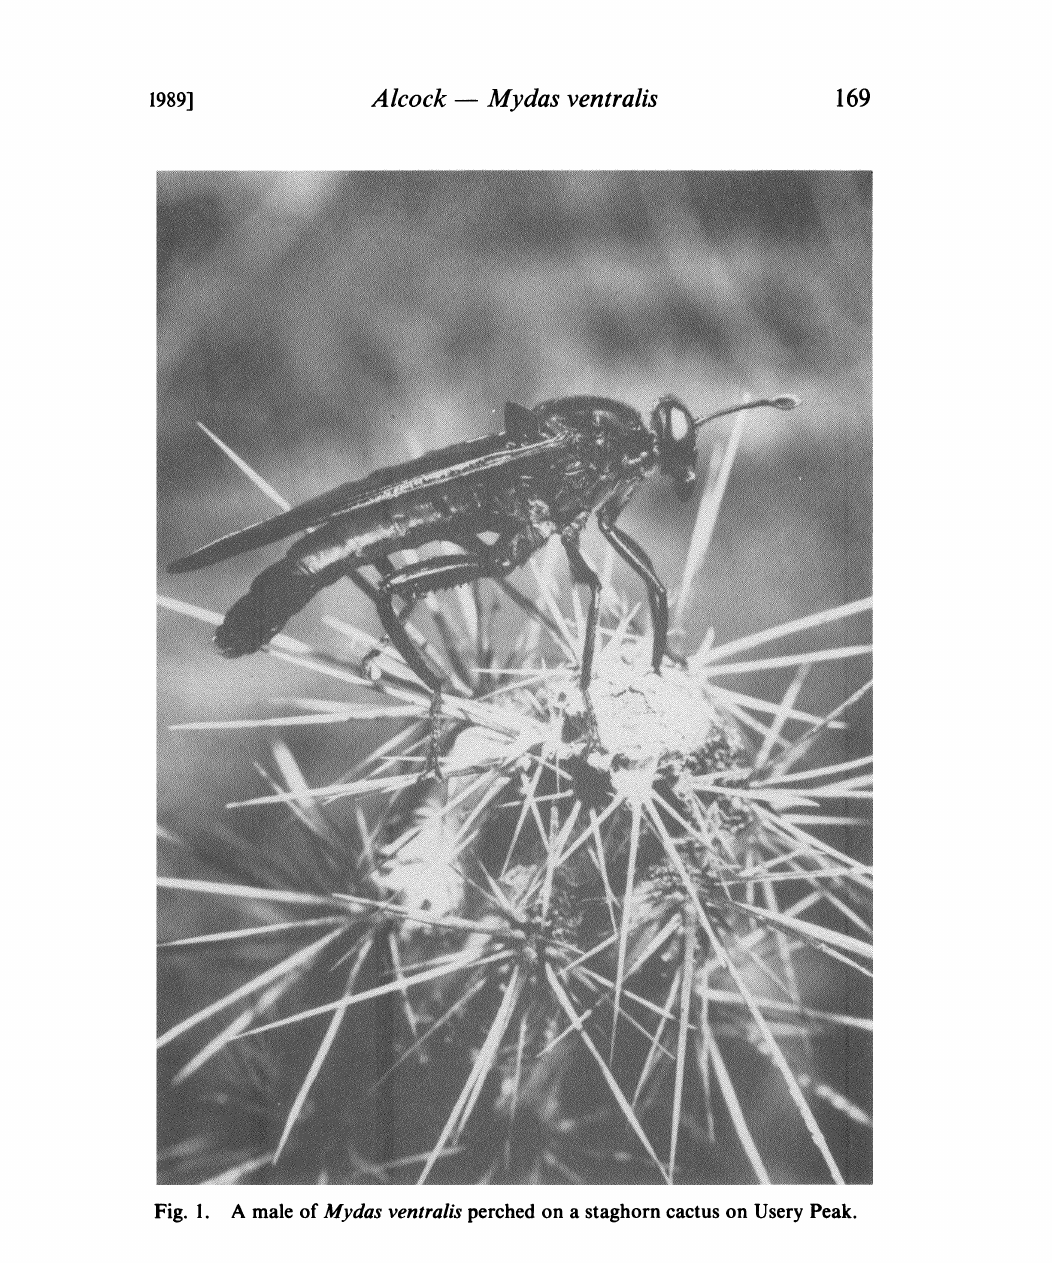
Fig. 1. A male of Mydas ventralis perched on a staghorn cactus on Usery